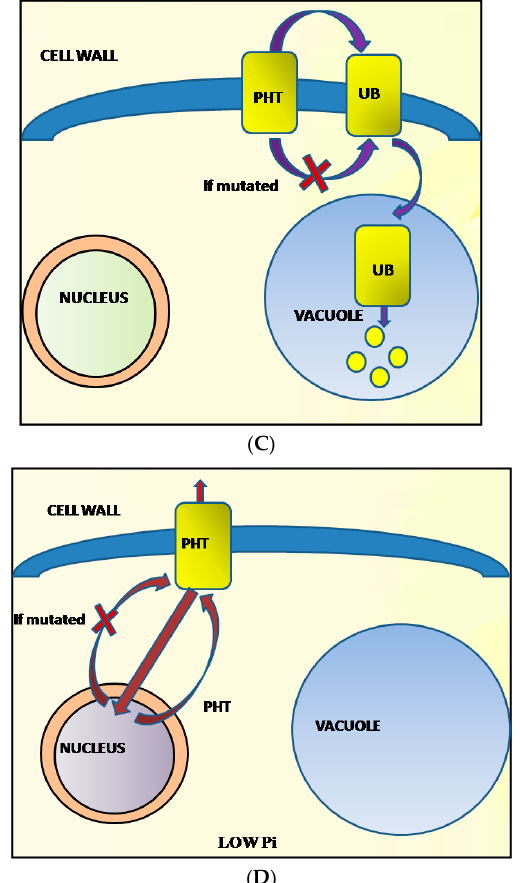
Figure 5. ( A ) Mode of action of native and mutated PHR genes at high Pi condition. ( B ) Mode of action of native and mutated PHR genes at low Pi condition. ( C ) Mode of action of native and mutated PHT genes at high Pi condition. ( D ) Mode of action of native and mutated PHT genes at low Pi condition. Table 2. Genome-wide association study for total dry weight (TDW), P concentration (PC), total P uptake (TPU), and P utilization efficiency (PUtE) studied using a mixed linear model (MLM) and compressed mixed linear model (CMLM). Conditio Trait a n b